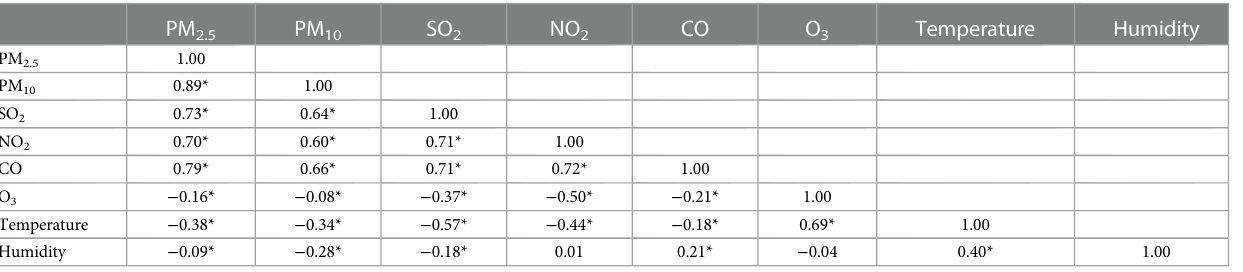
TABLE 4 Spearman correlation coef fi cients of air pollutants and meteorological